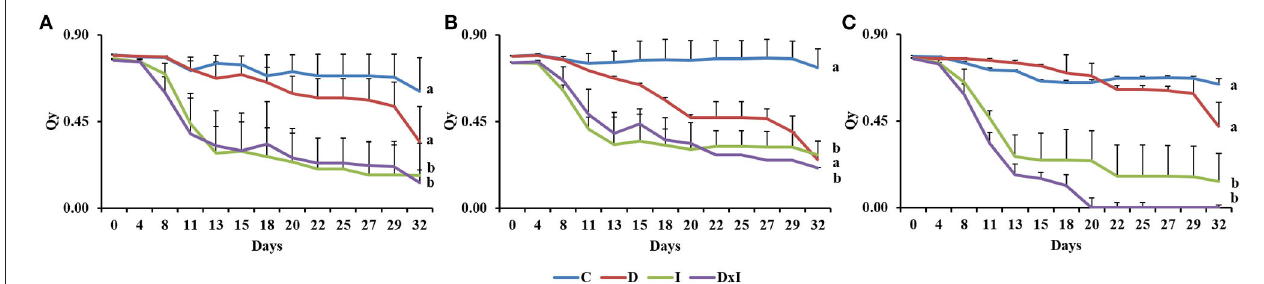
FIGURE 3 | Quantum yield of photosystem II (Qy) in the dark of adapted leaves from the three Q. ilex populations ( A , Seville; B , Granada; C , Almeria) under the control (C), drought (D), inoculation (I), and combined treatment (D × I). Values are mean ± SE for three biological replicates. Different letters, calculated from the area under the Qy curve, denote significant differences among treatments ( p < 0.05).